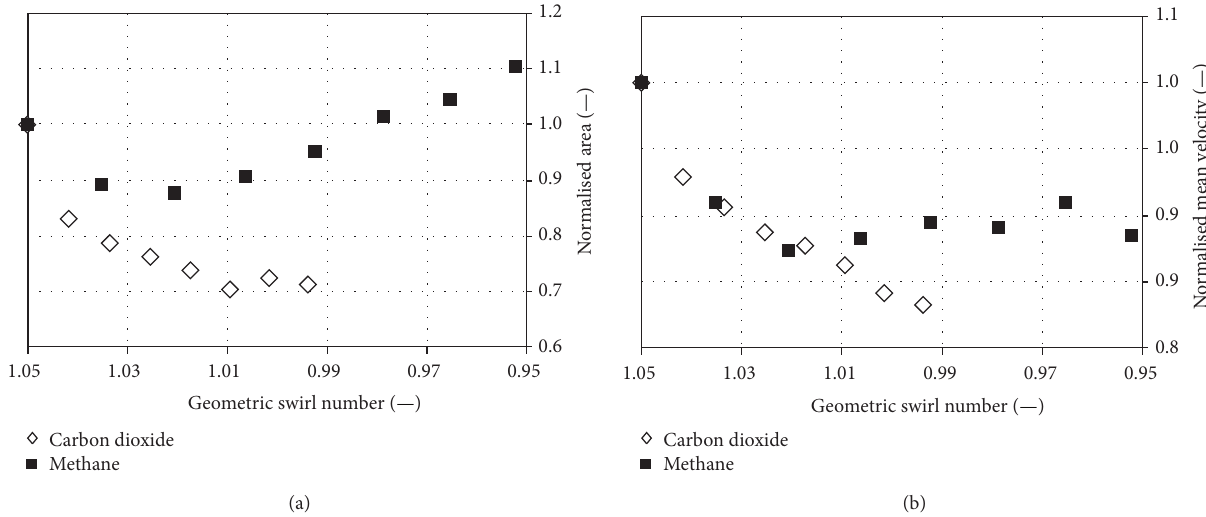
Figure 12: The normalised effect of the injection of carbon dioxide and methane on (a) the cross sectional area and (b) mean velocity of the HMFR.